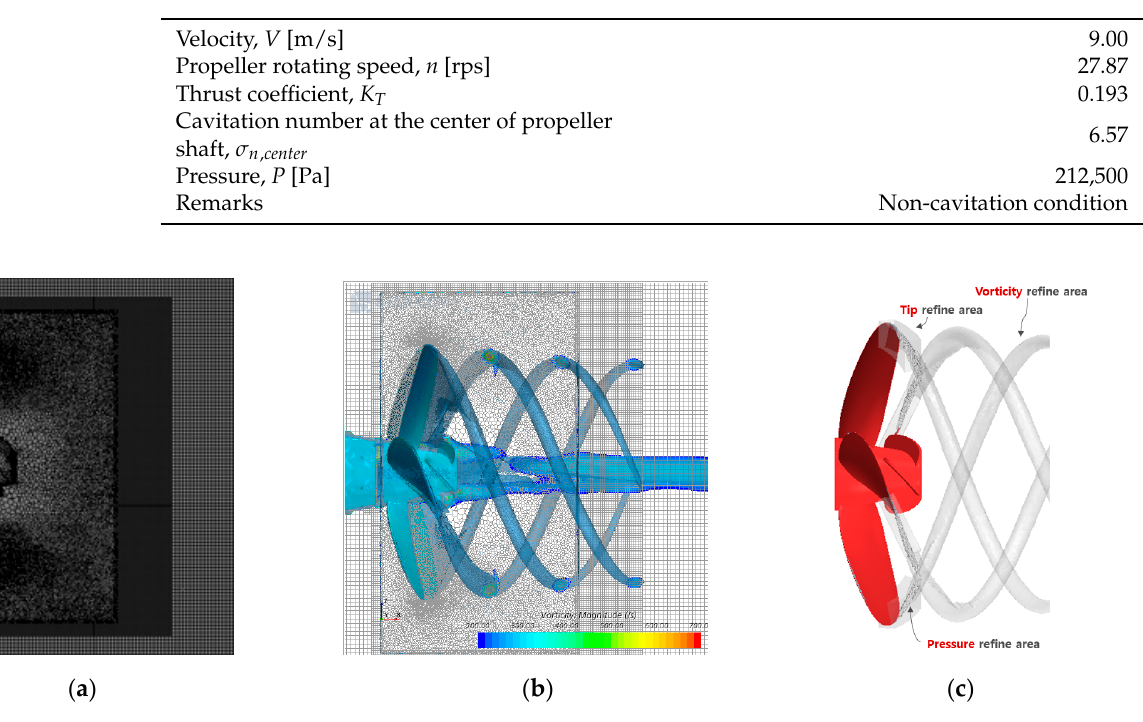
Figure 4. Mesh refinement of rotating region: ( a ) refined mesh, ( b ) vorticity contour, ( c ) refined mesh region.